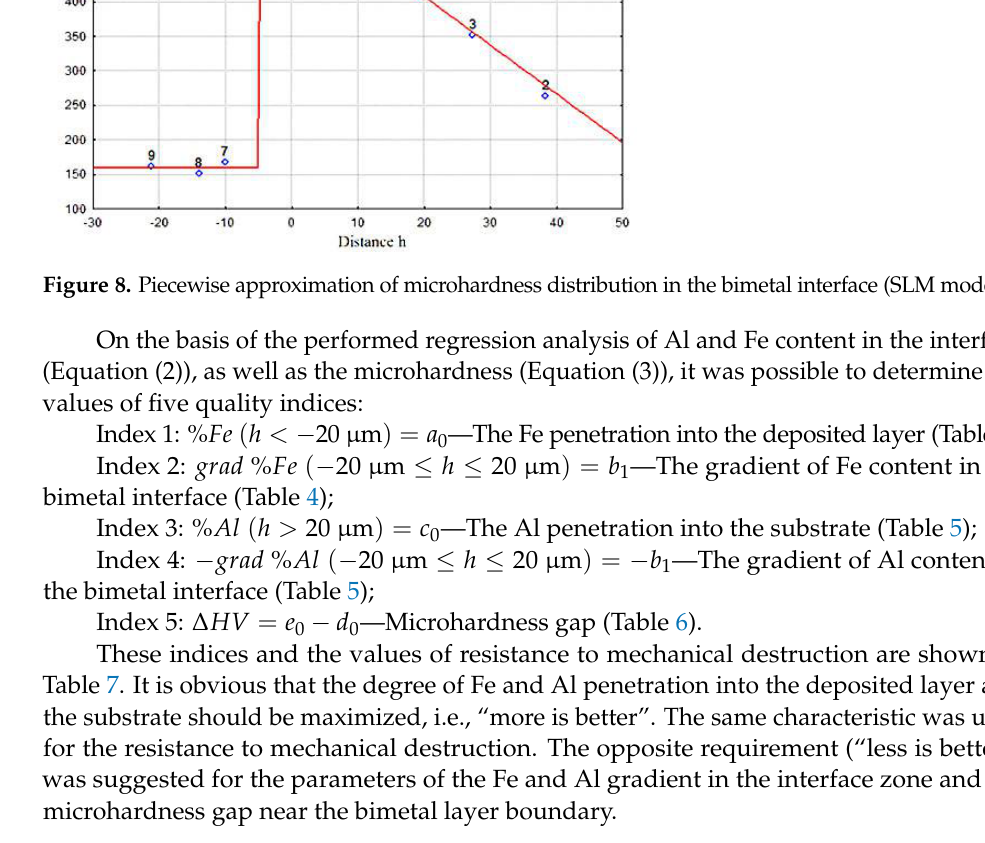
Table 7. Coefficients of gray relational analysis of quality indices for bimetal interface. Mode No.